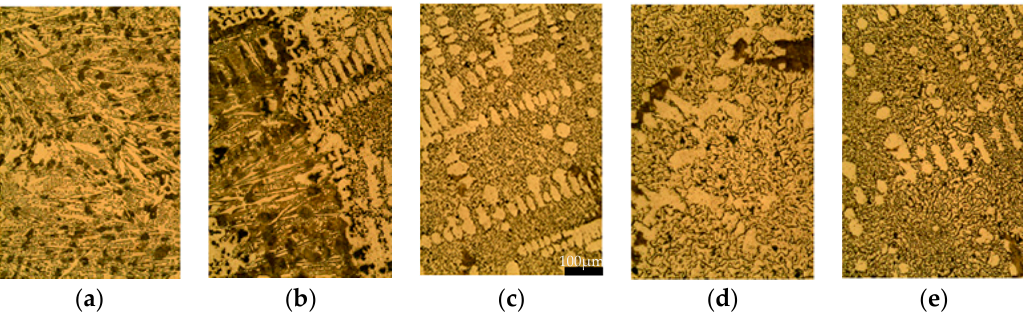
Figure 5. Micrographs (200 times magnification) etched in 3% Nital along the radial axis from ( a ) inside to ( e ) outside of the thimble, at ( a ) 66; ( b ) 70; ( c ) 75; ( d ) 80 and ( e ) 85 mm from the axis. Scale bar is the same for the five figures, 100 μ m.